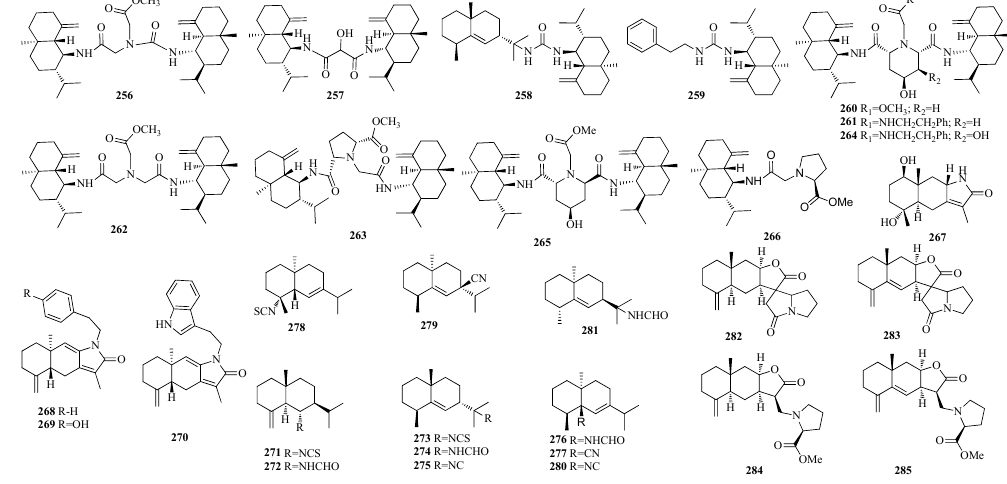
Figure 5. The structures of compounds 256 - 285.